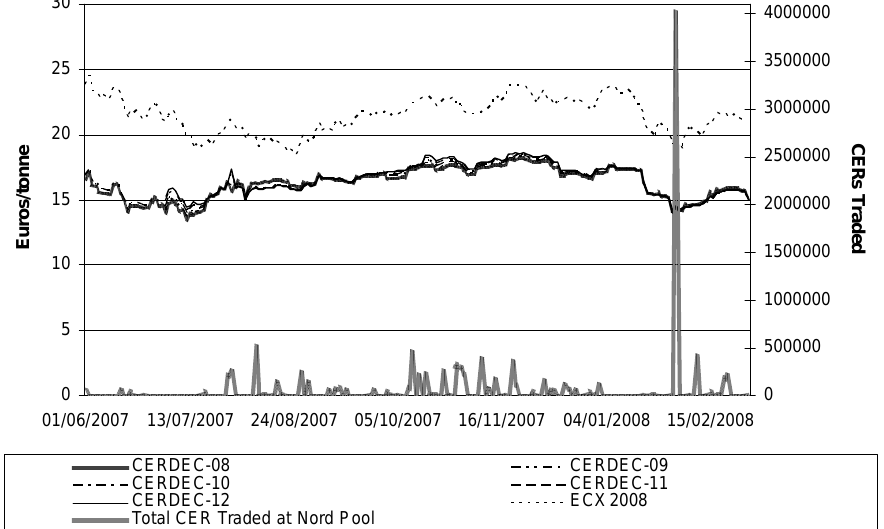
Figure 7. Certificate Emission Reduction Futures Prices and Volume in Nord